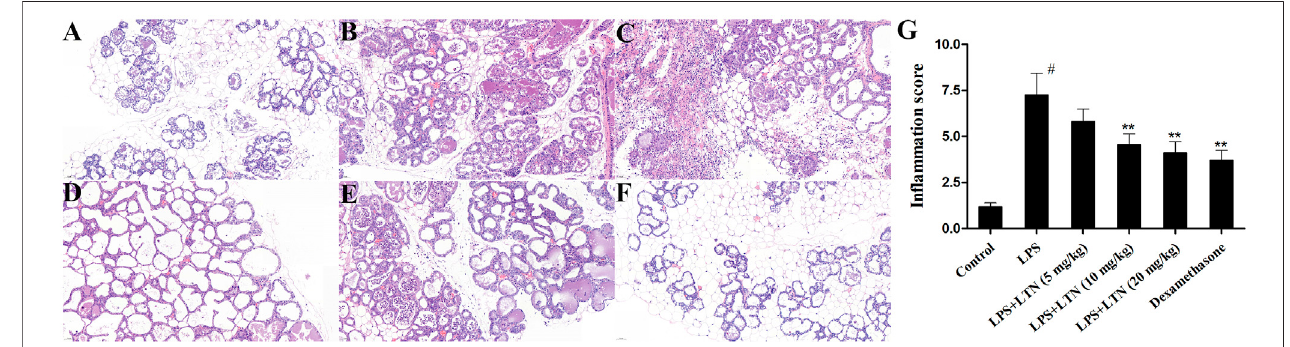
FIGURE 1 | Effects of lentinan on LPS-stimulated histopathological changes. Histopathological changes in mammary gland tissues (H and E). (A) Control group, (B) LPS group, (C – E) lentinan (5, 10, and 20 mg/kg) groups, (F) dexamethasone group, and (G) histopathological grade score. The blue arrow indicates the mammary gland tissue lesion area. All data are represented as the mean ± S.E.M. of three replicates. # p < 0.05 vs the control group. * p < 0.05 vs. the LPS group. ** p < 0.01 compared with the LPS group. *** p < 0.01 compared with the LPS